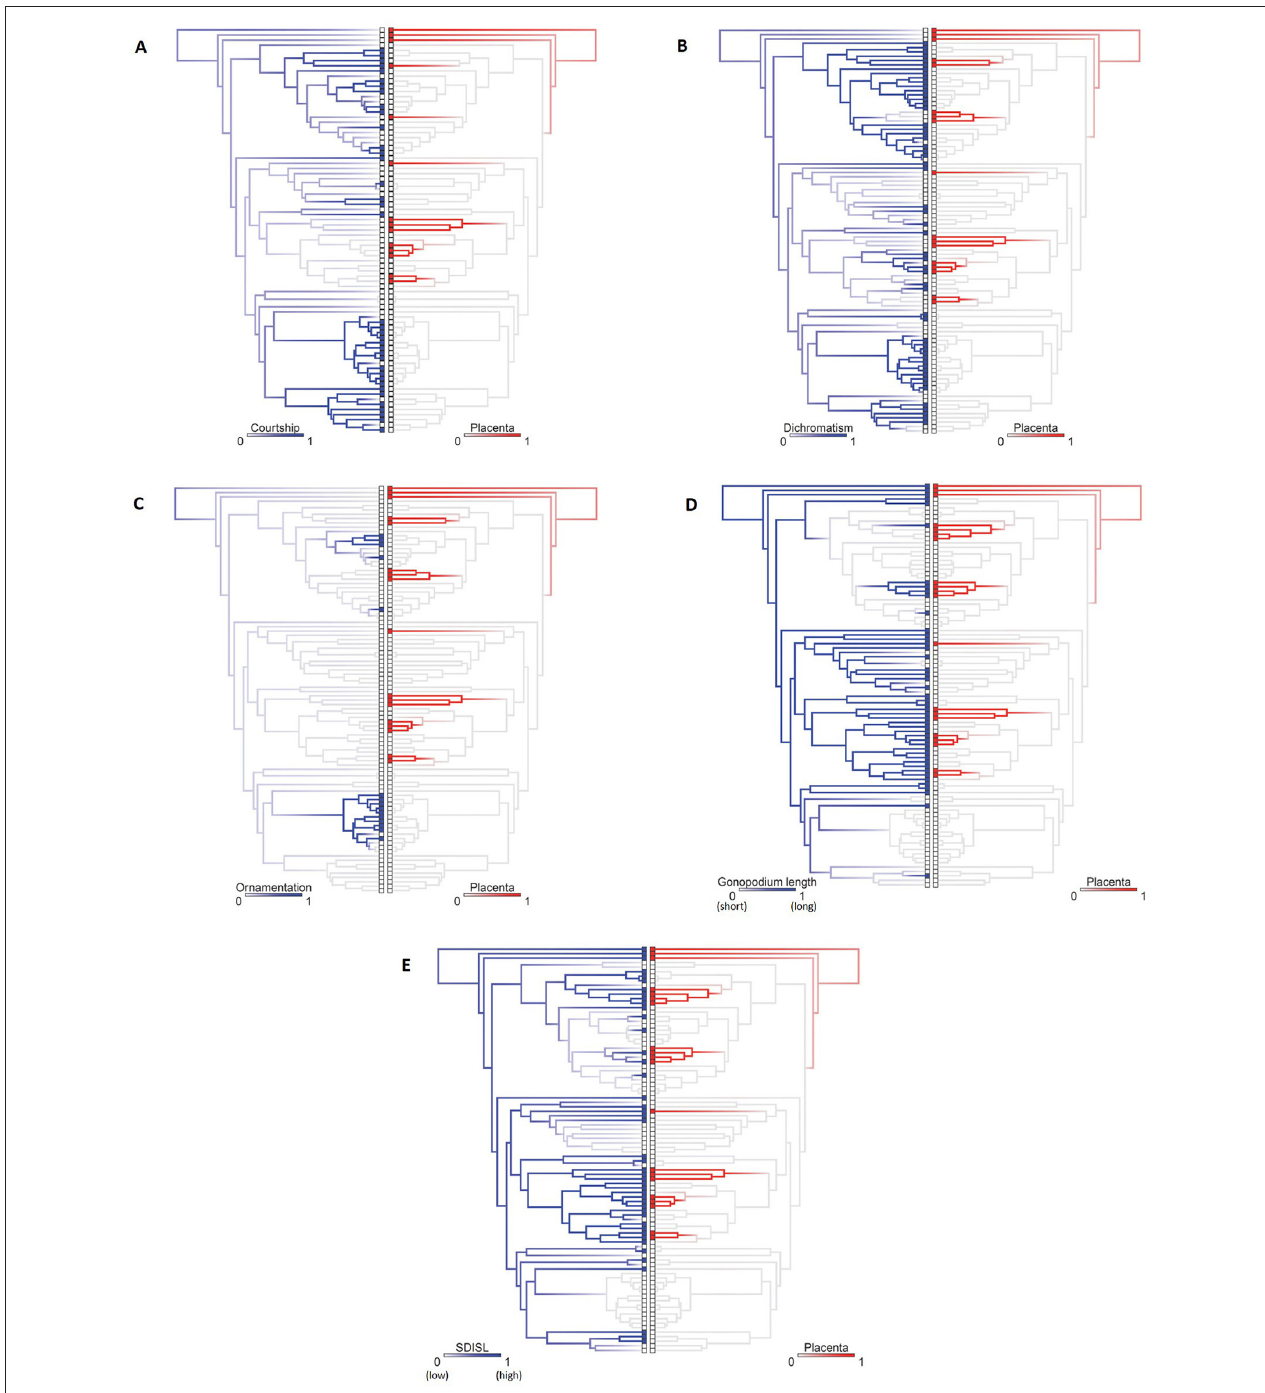
FIGURE 11 | Mirrored trees illustrating potential correlated evolution between (A) courtship, (B) dichromatism, (C) ornamentation, (D) relative gonopodium length, and (E) sexual dimorphism index (standard length) and the placenta. Ancestral state reconstructions of both binary traits by stochastic character mapping. Phylogeny restricted to species with both traits. Branch colors represent posterior probability densities of edge states based on 1000 stochastic character maps of each econstruction. BayesTraits Discrete analyses support dependent (i.e., correlated) evolution between placentation and the absence of courtship, the absence of sexual dichromatism and increased sexual size dimorphism (males much smaller than females) but not with absence of ornamentation or long relative gonopodium length (Furness et al., 2019). The lack of association between placentation and absence of ornamentation is almost certainly due to the limited sample size of species with ornamentation. However, even though not statistically supported, all origins of ornamentation are in non-placental lineages ( Xiphophorus and Poecilia ). Likewise, the placenta tends to evolve in lineages with long gonopodia. In sum, species with placentas tend to lack male courtship, dichromatism, and ornamentation, have long gonopdia, and have a high degree of sexual size dimorphism (males much smaller than females). Figures redrawn from Furness et al. (2019).